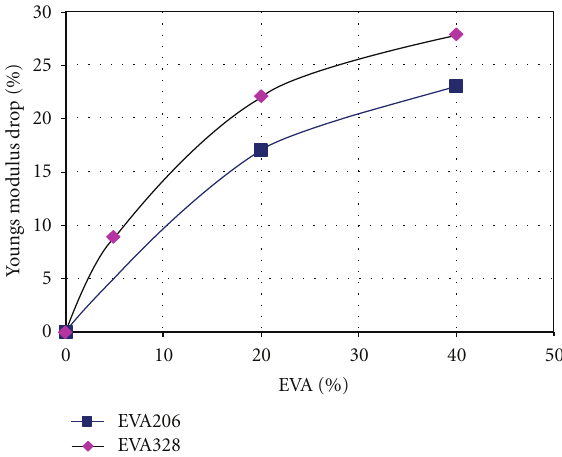
Figure 11: Storage modulus as a function of VA content.